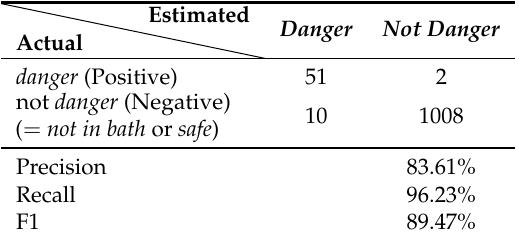
Table 3. Danger detection performance of the danger-pose detection